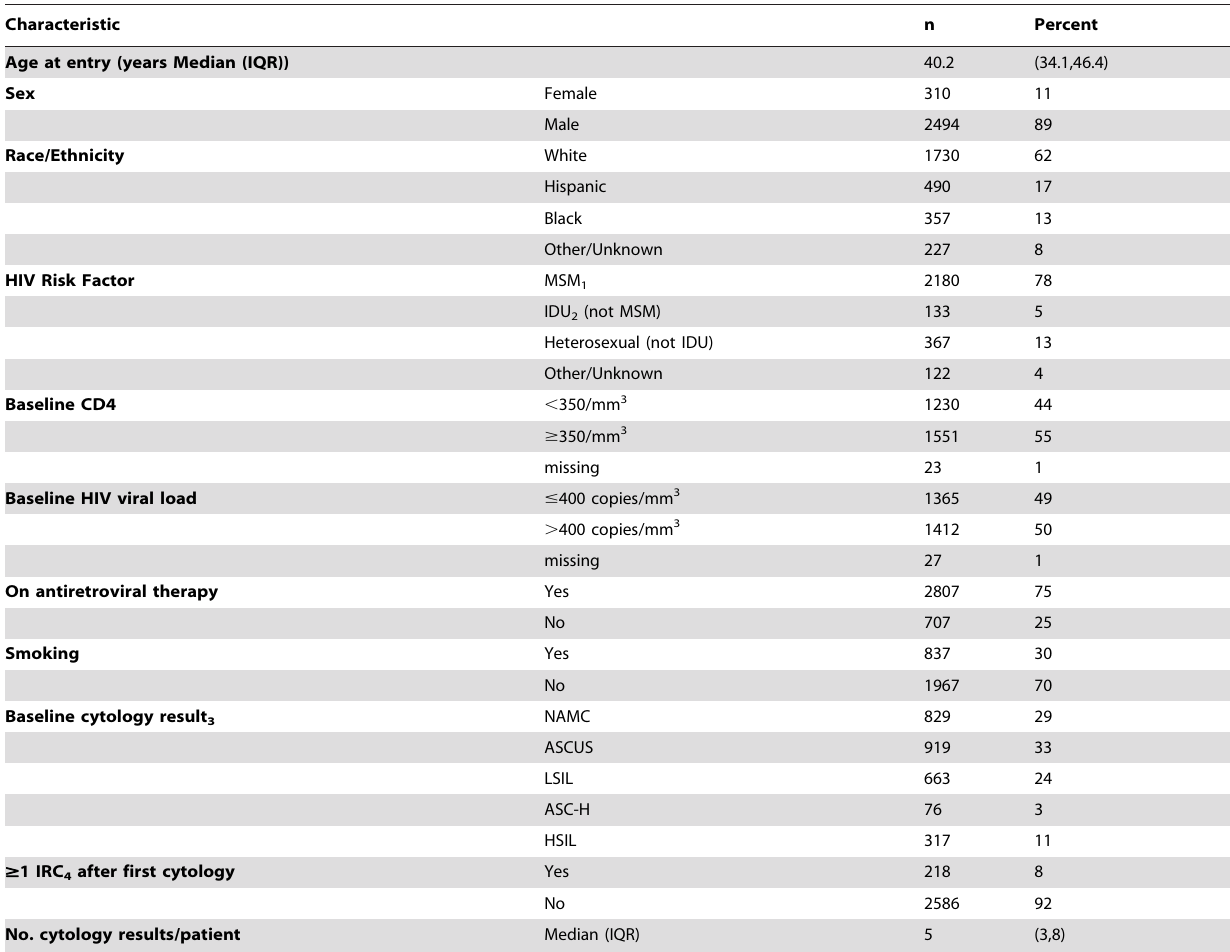
Table 1. Study Participant Characteristics (n